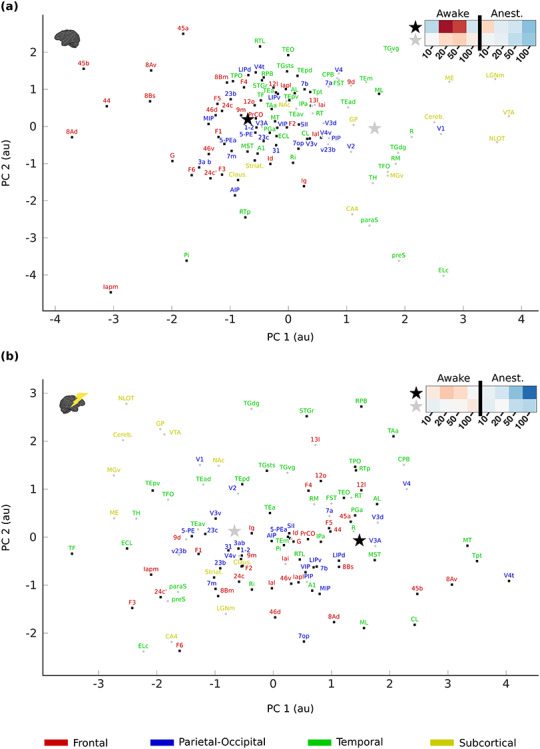
Clustering of the functional responses to VTA-EM. An unsupervised k-means clustering analysis on the ROI data of both the contralateral (a) and ipsilateral (b) hemispheres revealed 2 clusters in both cases. Individual ROIs from the 2 clusters are denoted by black (cluster 1) and gray (cluster 2) dots. Centroids of these clusters are represented by the stars in black (cluster 1) and gray (cluster 2). The functional profiles associated with the centroids are displayed in the top right of the 2 panels. The names of the ROIs are colored according to the large anatomical subdivisions of the brain they belong to (for a full overview of the ROIs: Supplementary Material S5). PC = Principal Component.